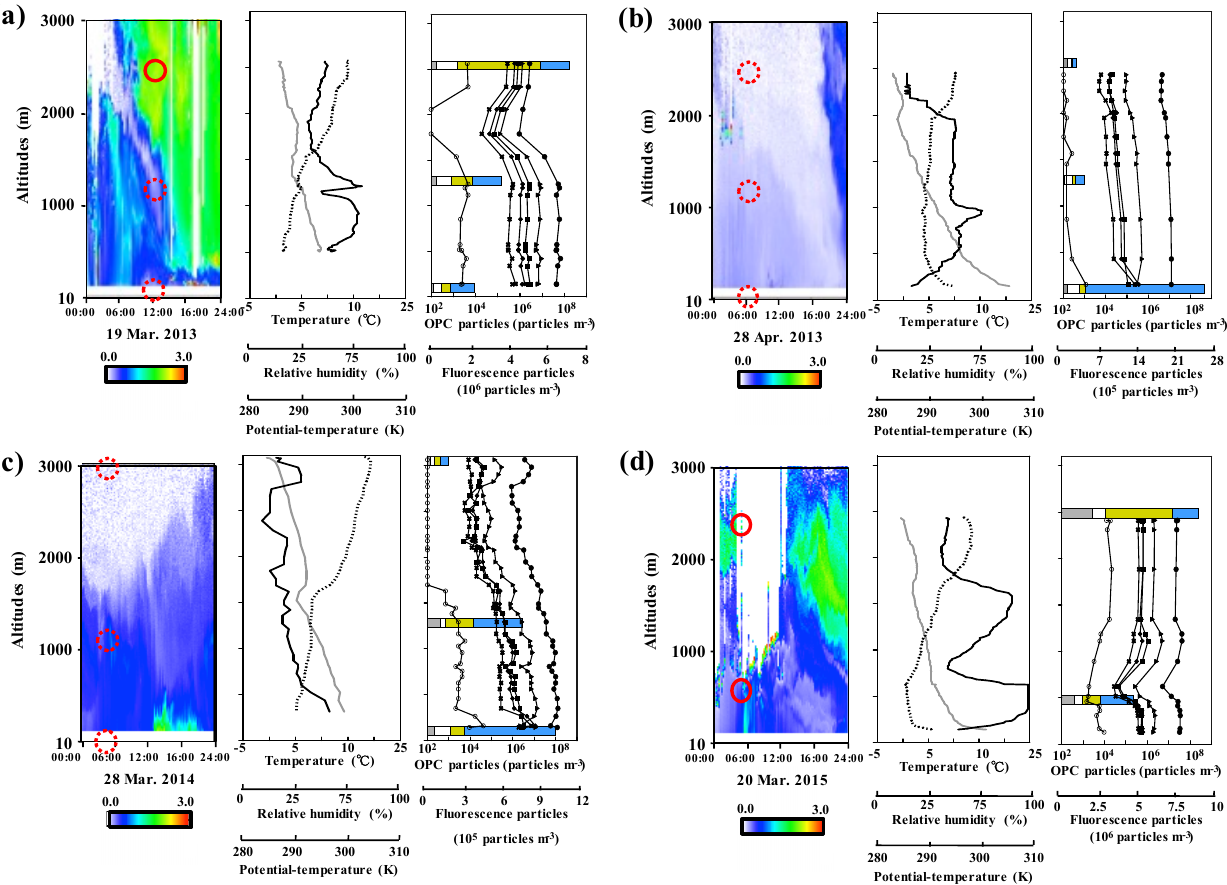
Figure 2. Lidar observation of the depolarization ratio in Toyama city, as well as vertical changes in temperature, relative humidity, and potential temperature and vertical distributions of concentrations of OPC-counted particles and DAPI-stained particles from the four sampling events on 19 March 2013 (a) , 28 April 2013 (b) , 28 March 2014 (c) , and 20 March 2015 (d) . The red circles in the lidar images indicate that the sampling air included dust mineral particles (solid line) or that dust-event influences are absent at the altitudes on the sampling time (dotted line). OPC-counted particles were categorized according to diameter sizes of 0.3–0.5µm (closed squares), 0.5–0.7µm (closed triangles), 0.7–1.0µm (closed circles), 1.0–2.0µm (closed diamonds), 2.0–5.0µm (crosses), and > 5.0µm (open circles). DAPI-stained particles were classified into microbial particles (blue bars), white particles (white bars), yellow fluorescent particles (yellow bars), and black carbon (grey